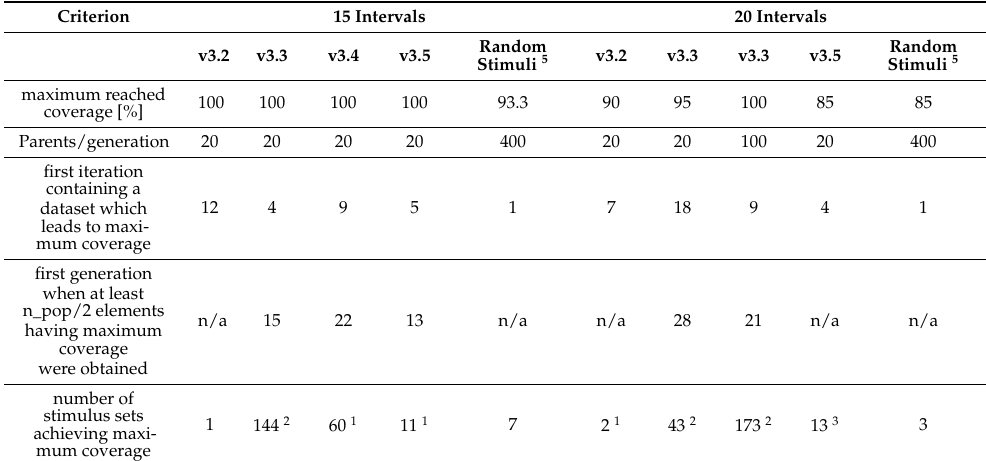
Table 6. Results obtained when the smart lamp controller was stimulated with values provided by programs based on genetic